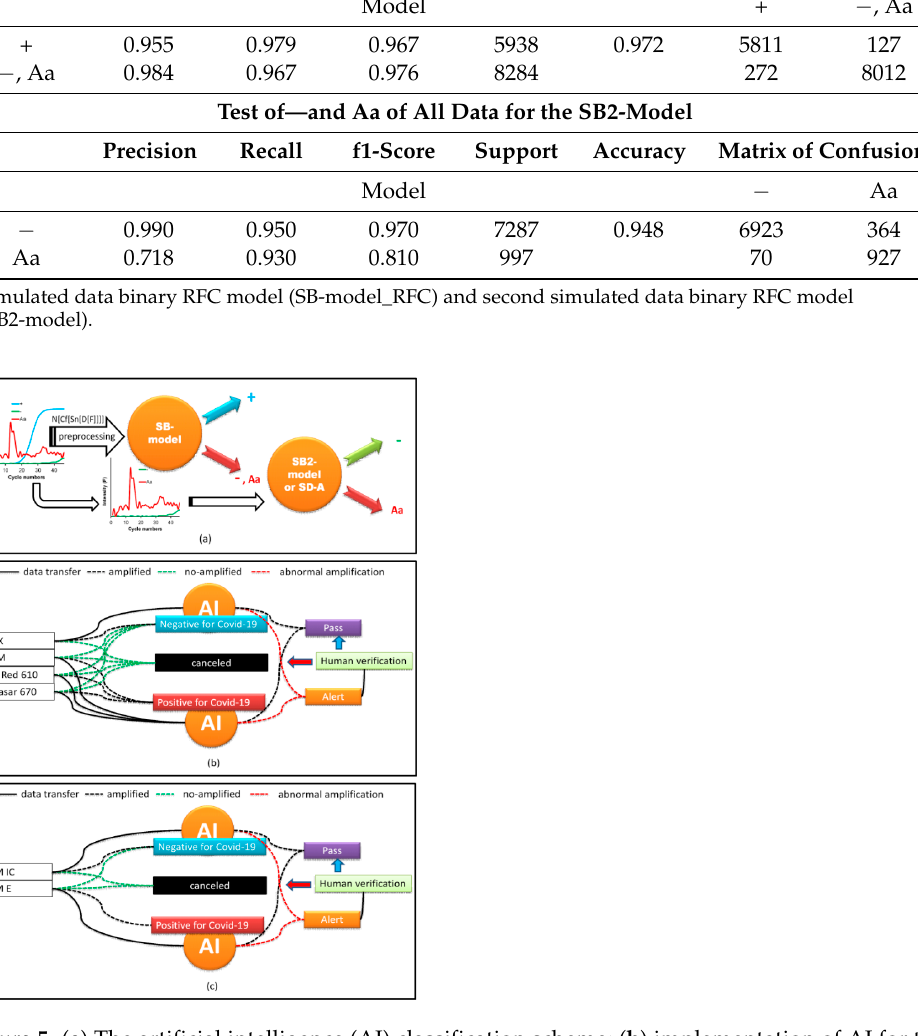
Figure 5. ( a ) The artificial intelligence (AI) classification scheme; ( b ) implementation of AI for the first PCR kit for COVID; ( c ) implementation of AI for the second PCR kit for COVID. Table 4. Confusion matrix and evaluation criteria for the test using all data for SB-model_RFC and SB2-model.